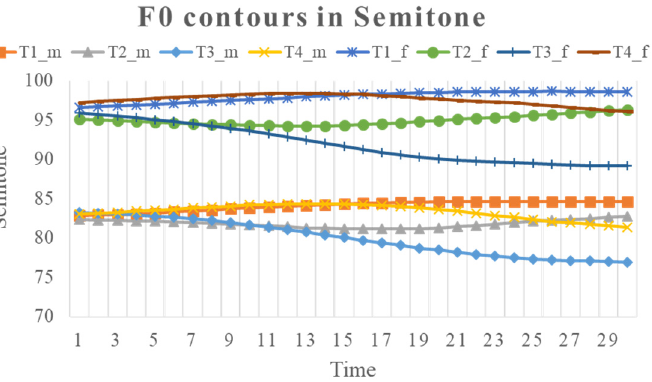
Figure 3. Mean time-normalized syllable-sized semitone contours of four Mandarin tones, averaged separately for female and male speakers.